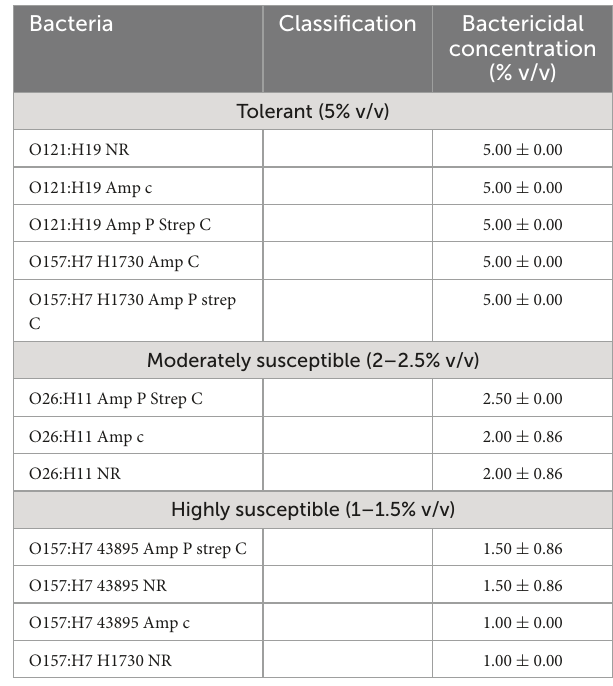
TABLE 2 Classification of the bacterial strains according to bactericidal concentrations of lactic